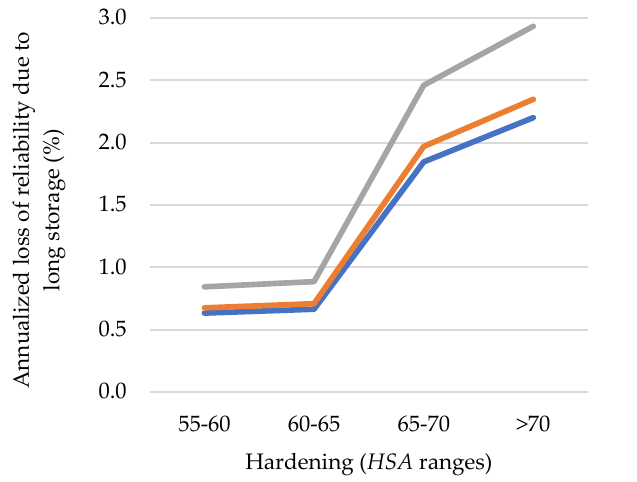
Figure 16. Annualized loss of reliability due to a long storage. In the range of 55–65 HSA , the loss of reliability due to storage was small, with hardly any difference between 55 and 60 and 60 and 65 (zone of acceptable values). The loss of reliability accelerated in the range 65–70 (the slope is greater), being higher from 70 Shore A. Equation (8) provides the time to damage ( TTD ) that is calculated from TTIL obtained from Equation